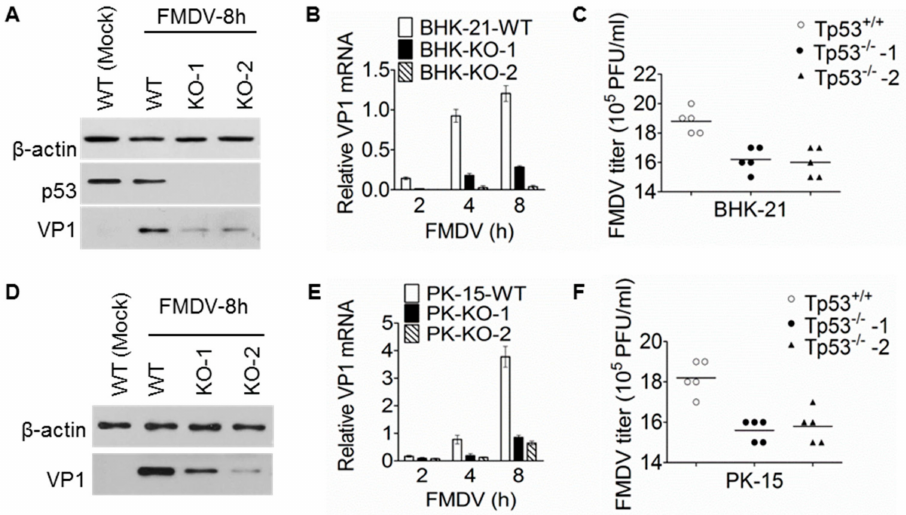
Figure 3. p53 knockout inhibited FMDV replication in BHK-21 and PK-15 cells. ( A – C ). p53